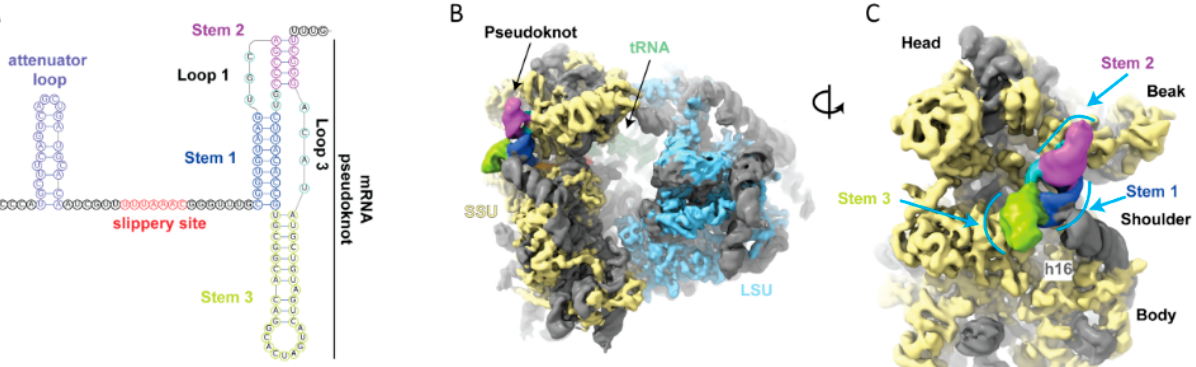
Figure 3. ( A ) Schematic of secondary structure elements regulating -1 frameshifting in SARS-CoV-2. As visualized by cryo-EM [98], the frameshift stimulatory pseudoknot consists of three stems, interconnected by unstructured single-stranded loops. ( B ) Visualization of the stimulatory pseudknot bound to an elongating ribosome at the vicinity of the frameshift site. The intact structured pseudoknot is present at the entry of the mRNA channel on the ribosomal small subunit (SSU). SSU proteins are colored in yellow, LSU proteins in blue, and rRNA in gray. The pseudoknot is colored as per secondary structure description in panel A. ( C ) Pseudoknot as observed from the solvent exposed side of the SSU. Stems 1 and 2 are quasi co-axially stacked, with Stem 3 being perpendicular. Stem 1 interacts with helix 16 of 18s rRNA, potentially aiding the pseudoknot in restricting ribosomal translocation. These figures were adapted from Bhatt et al. [98].